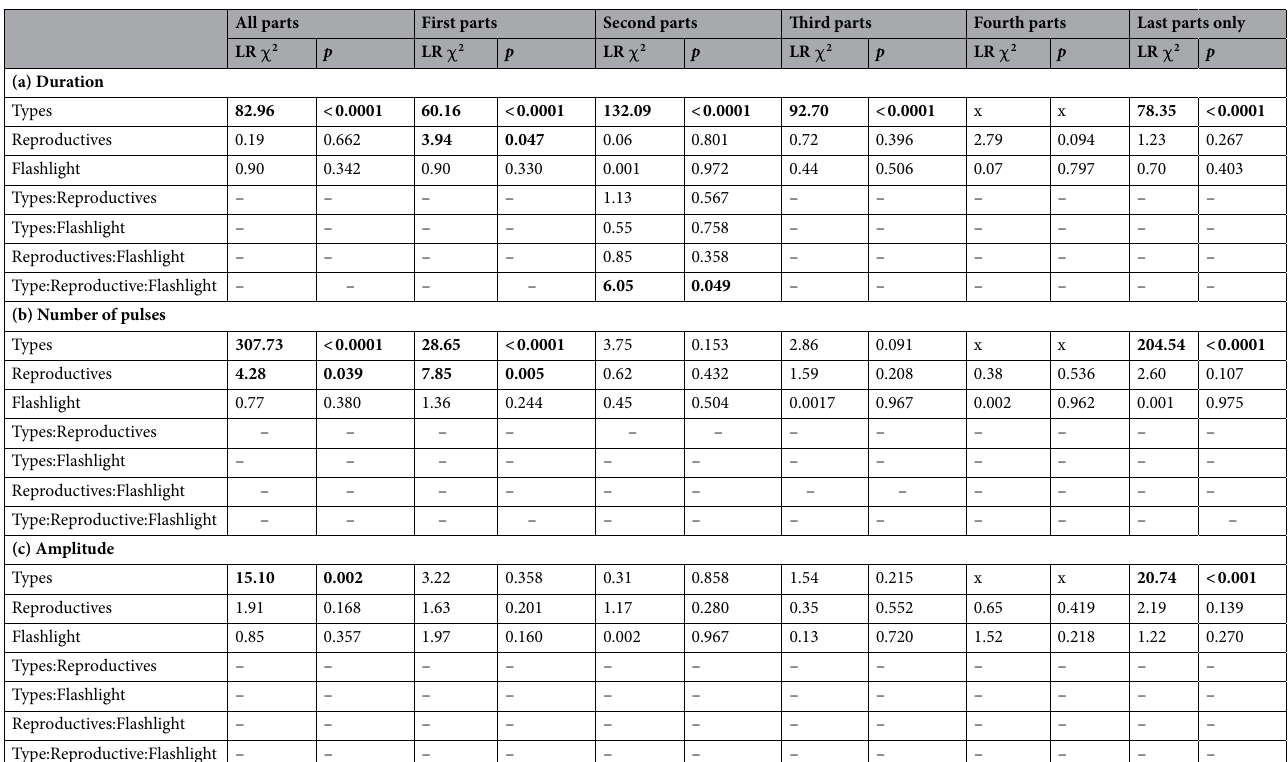
Table 1. Statistical table of the tested effects: the type of body-shaking (BS1-4), the presence of reproductives, the flashlight, and all their interactions. Each effect is reported for (a) the duration, (b) the number of pulses, and (c) the amplitude. Data are shown with all parts pooled together (the entire vibration events), the first parts only, the last parts only, and each part separately. Significant p value are in